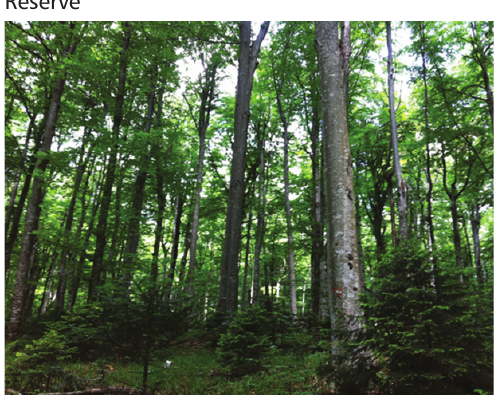
FIGURE 1. Beech stand in the Medveđak Forest Reserve